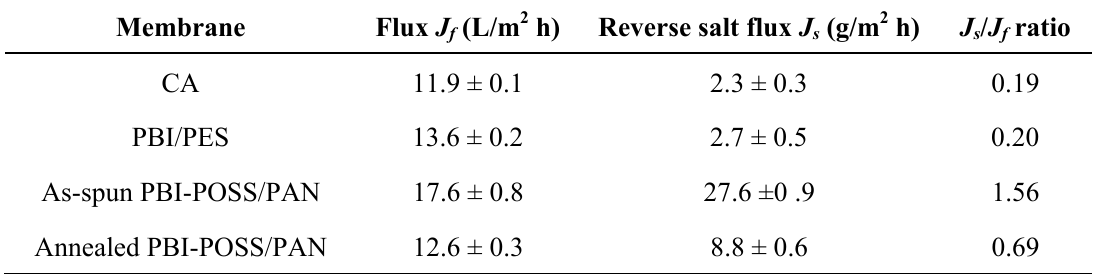
Table 2. Forward osmosis (FO) performance of CA, PBI/PES, as-spun PBI-POSS/PAN and annealed PBI-POSS/PAN hollow fiber